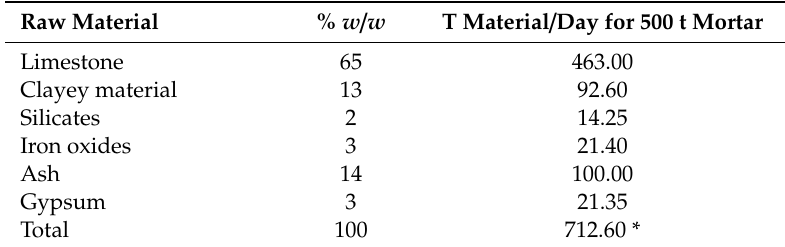
Table 4. Raw materials in tones for daily mortar production